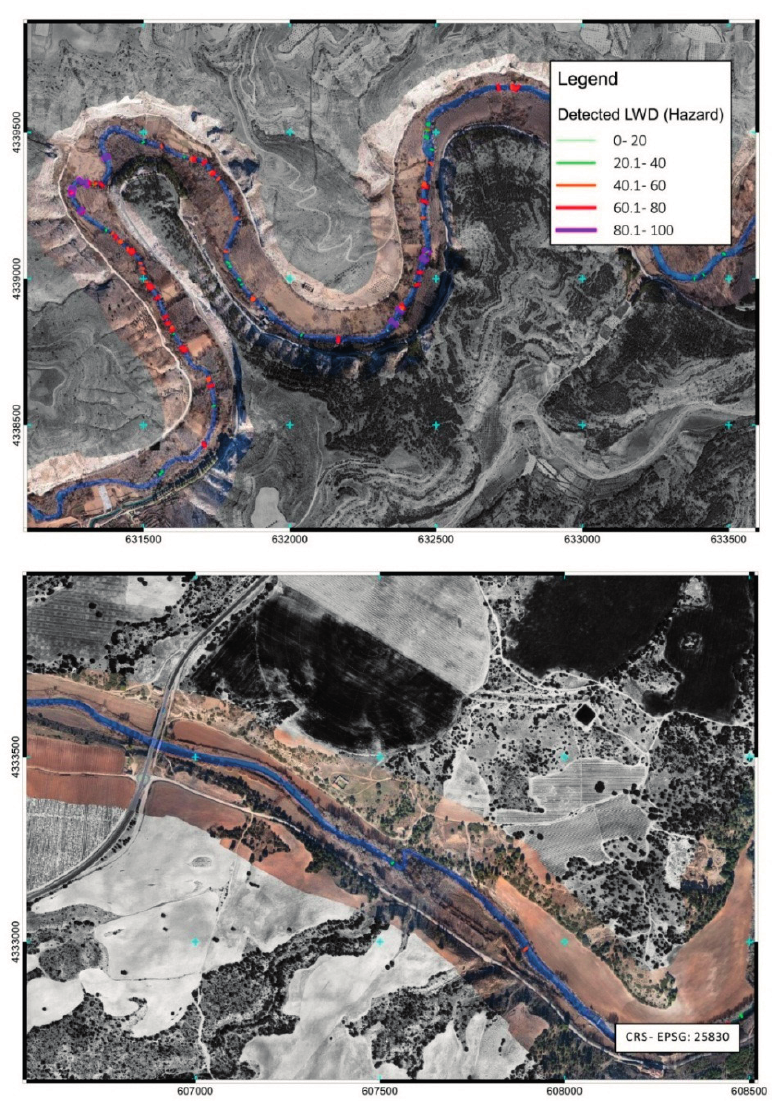
Figure 8. Two different stretches of the Júcar River where LWD was detected, with high and low density of LWD